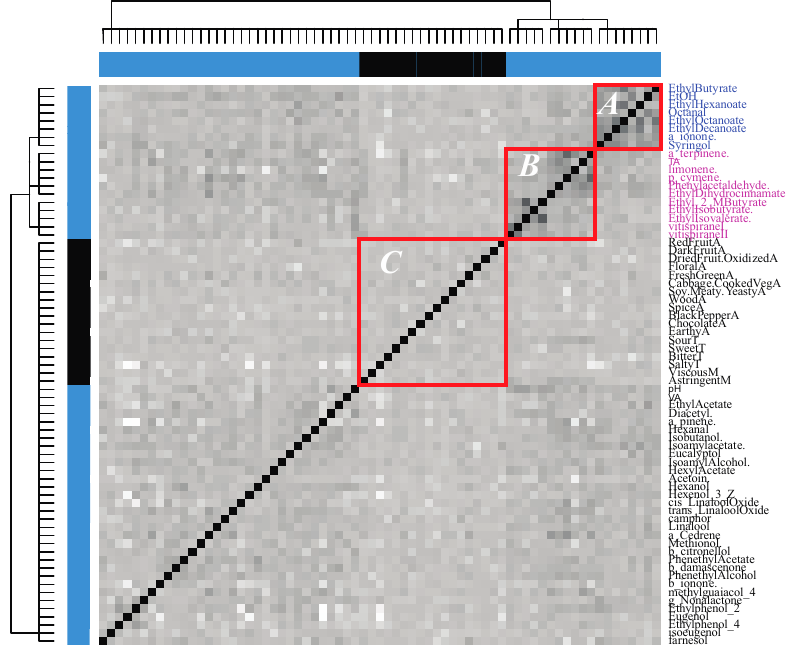
Figure 1. Clustering the 69 characteristics of the Malbec wines from California and Argentina. The chemical and sensory characteristics of the different Malbec wines were first compared in pairs, using a mutual entropy measure (see text for details). The all-against-all entropy distance matrix is then used to cluster those characteristics using DCG. The resulting heat map is shown. Chemical and sensory characteristics are highlighted in blue and black, respectively. Three subgroups of those characteristics are identified, and labeled as A, B and C on the heat map. The color scale white-black used to represent the heat map corresponds to the interval [0,1] for the mutual entropy, with black mapping to 0 and white mapping to 1.